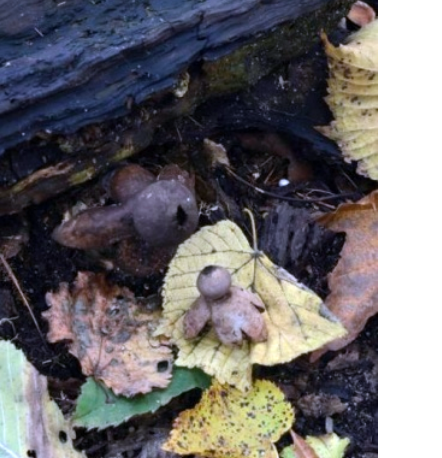
Figure 2 Geastrum fornicatum . Photo by B.